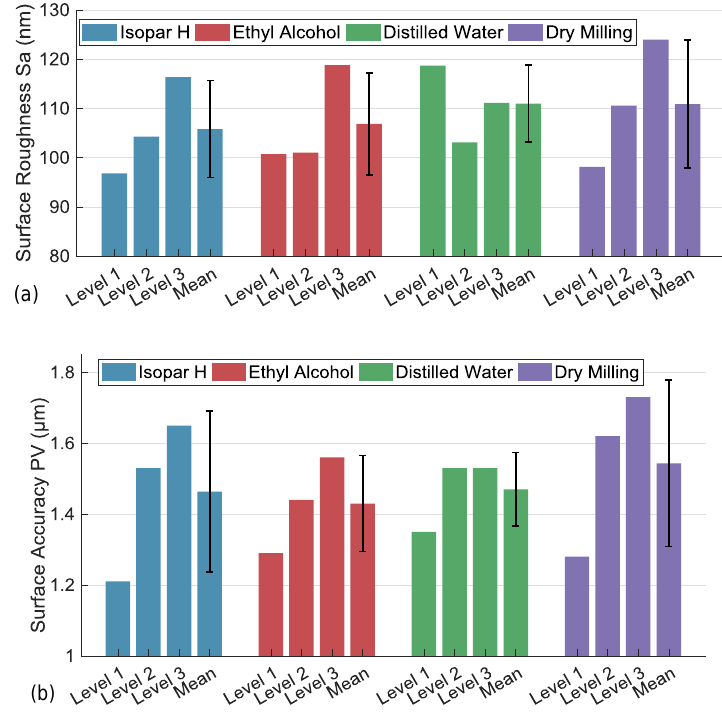
Figure 5. Surface quality of work piece micromilled under different coolants and methods. ( a ) surface roughness of the work piece; ( b ) surface accuracy of the work piece.